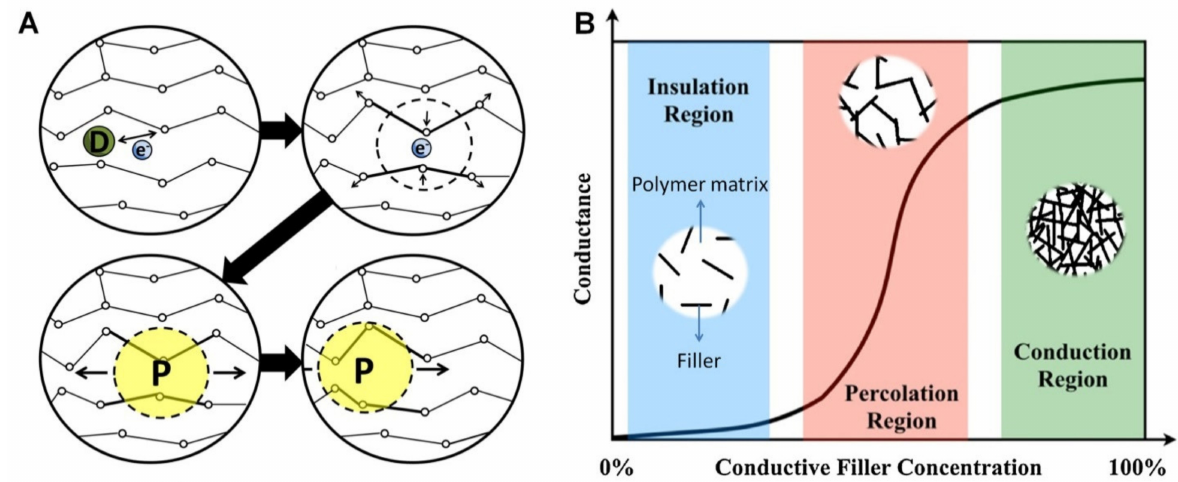
Figure 3. ( A ) Schematic of electrical conductivity of conductive polymers; where, the dopant D creates a delocalized charge (by adding or removing an electron to/from the polymer chain), which is then localized (energetically favourable) and surrounded by a local distortion of the crystal lattice, creating polaron P (a radical ion associated with a lattice distortion), which then travels along the polymer chain to conduct electricity. Adapted with permission from Ref. [16]. Copyright 2014, Elsevier. ( B ) Schematic of percolation behaviour and electrical conductance as a function of conductive filler concentration in an insulting matrix. Adapted with permission from Ref. [3]. Copyright 2019,